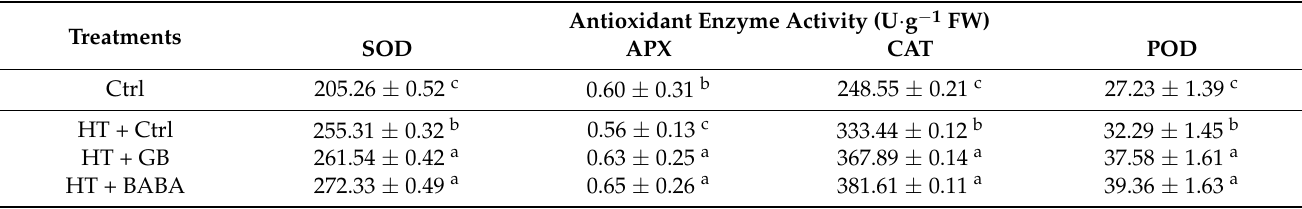
Table 3. Effects of GB and BABA on antioxidant enzyme activity in Chinese cabbage under heat stress.